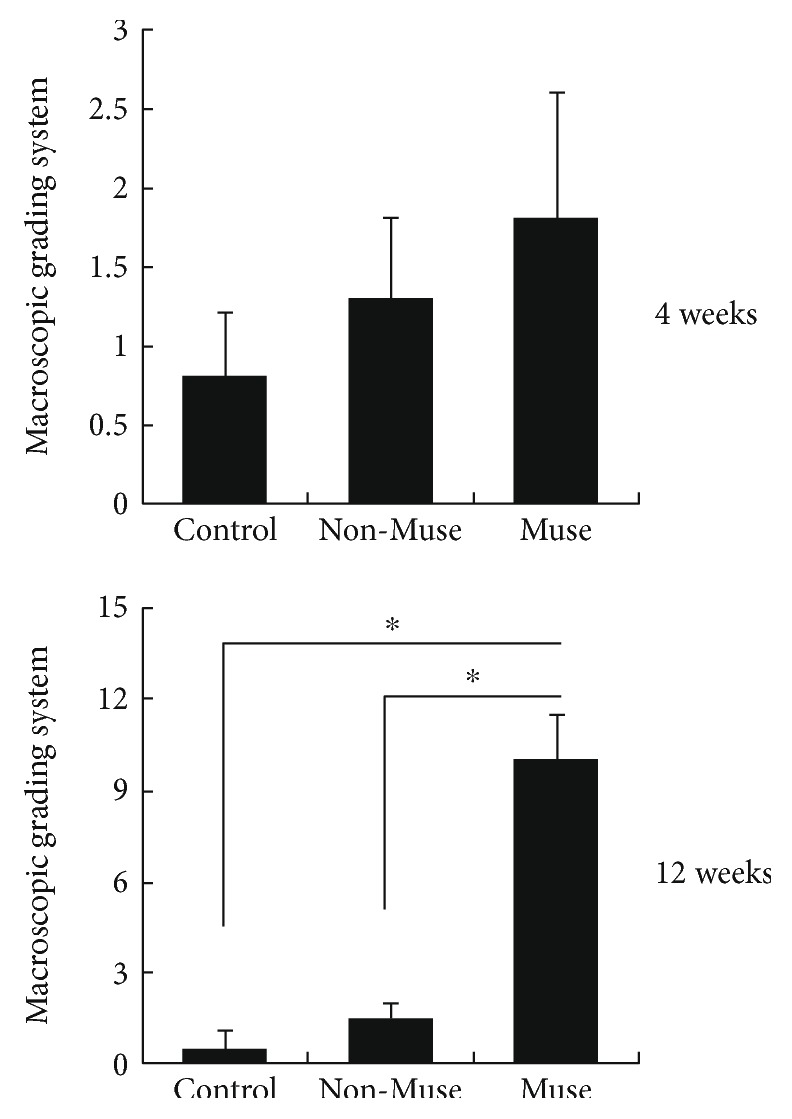
The macroscopic grading system revealed no significant difference between the groups at 4 weeks. However, at 12 weeks, the Muse group showed significantly better results than the other groups. ∗P < 0.05.